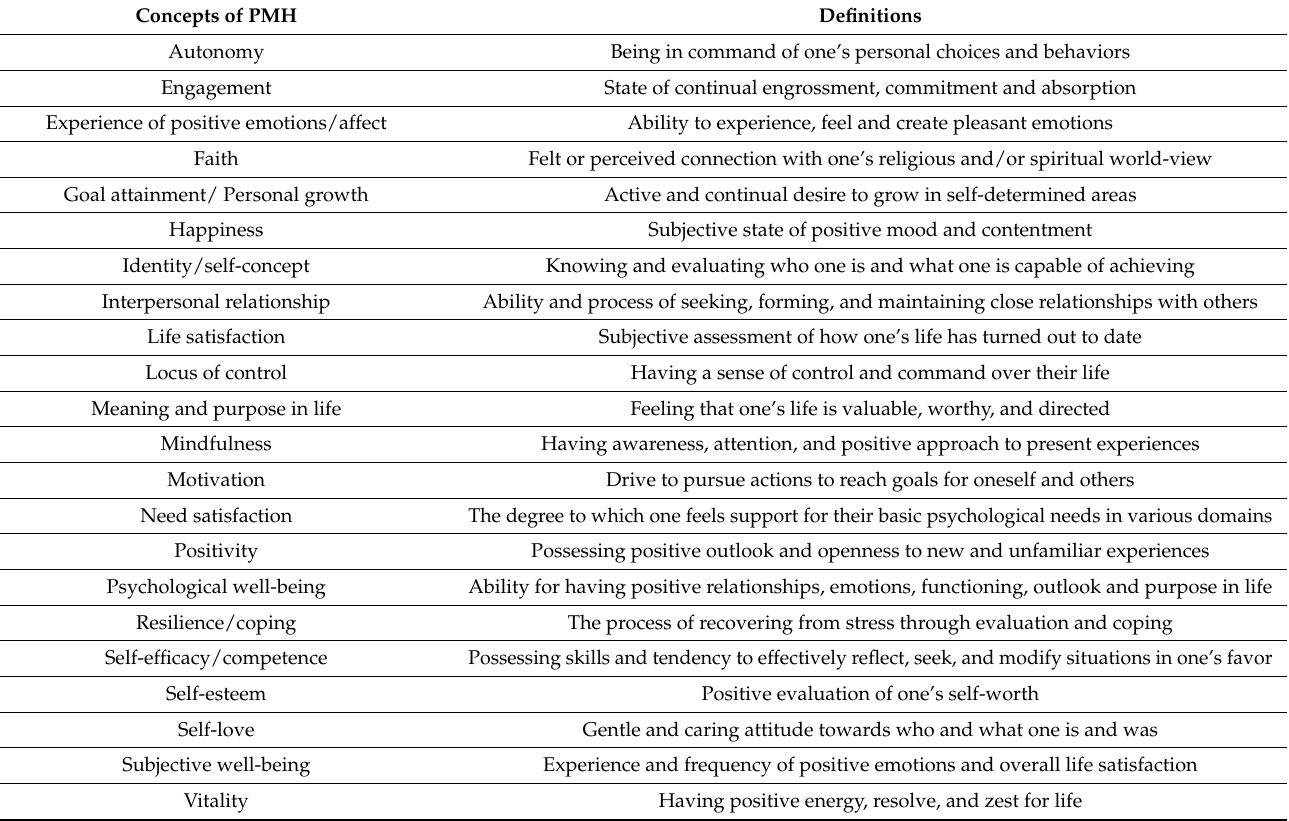
Table 2. Summarized operational definitions of youth positive mental health